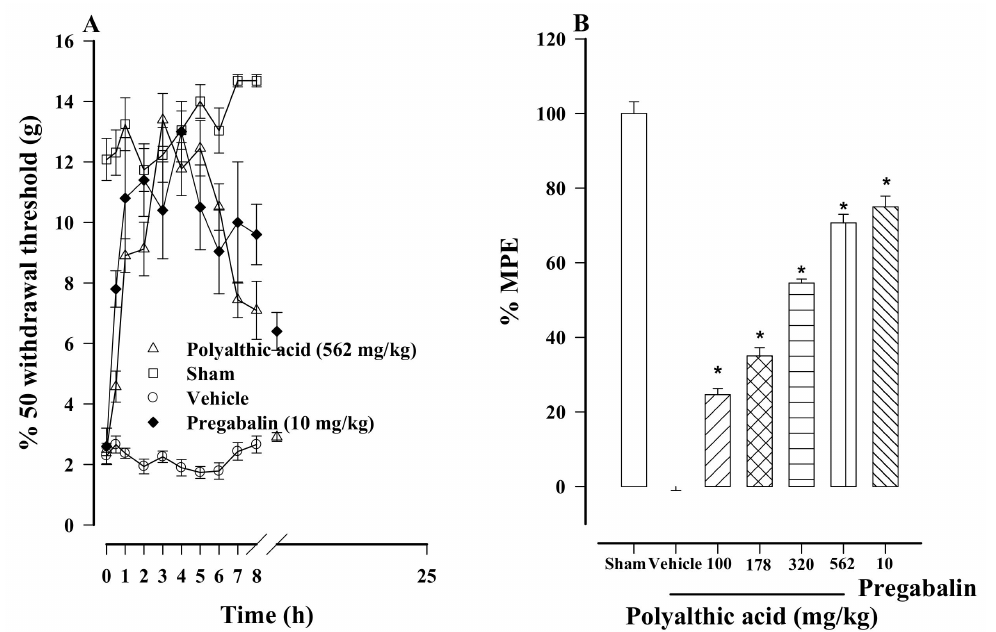
Figure 4. ( A ) Temporal course of the antiallodynic activity afforded by the oral administration of polyalthic acid (562 mg/kg) and pregabalin (10 mg/kg) to rats with an L5/L6 spinal nerve ligation. Data are expressed as the intensity of stimulus required to induce a response in 50% of the applications. ( B ) Dose-dependent antiallodynic effect of polyalthic acid administered at 100 to 562 mg/kg. Data are expressed as a percentage of activity against allodynia, considering the maximum possible effect (% MPE). Bars represent the mean ± SEM ( n = 6). * p < 0.0001 vs. the vehicle group, as determined